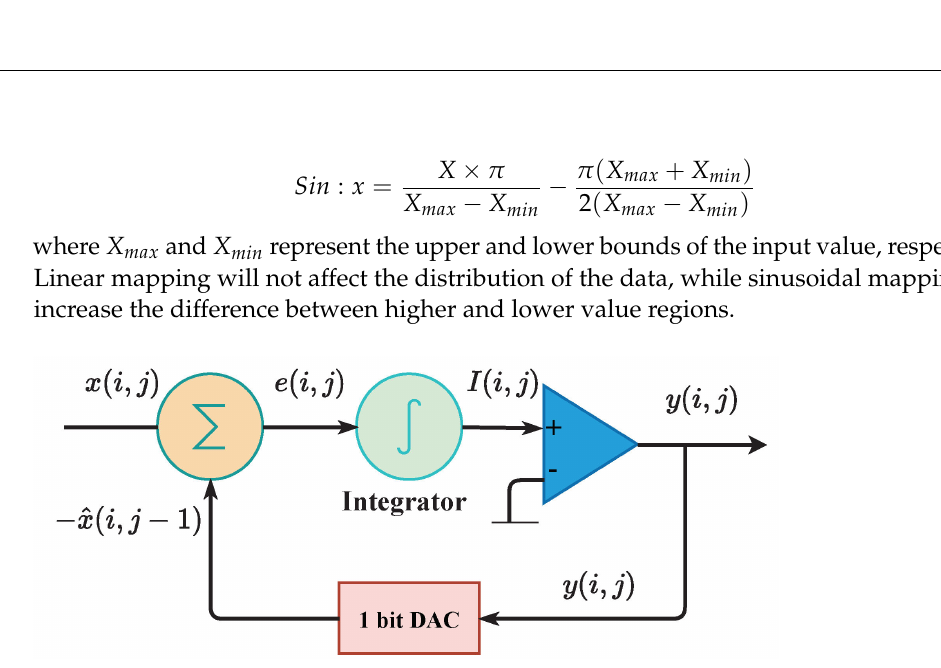
Figure 2. The encoding process of the SDE. Because the integrator’s value I ( i , j ) is not reset during encoding, each input value is affected by others. The return value of 1-bit DAC ˆ x ( i , j ) ∈ {− 1,1 } .